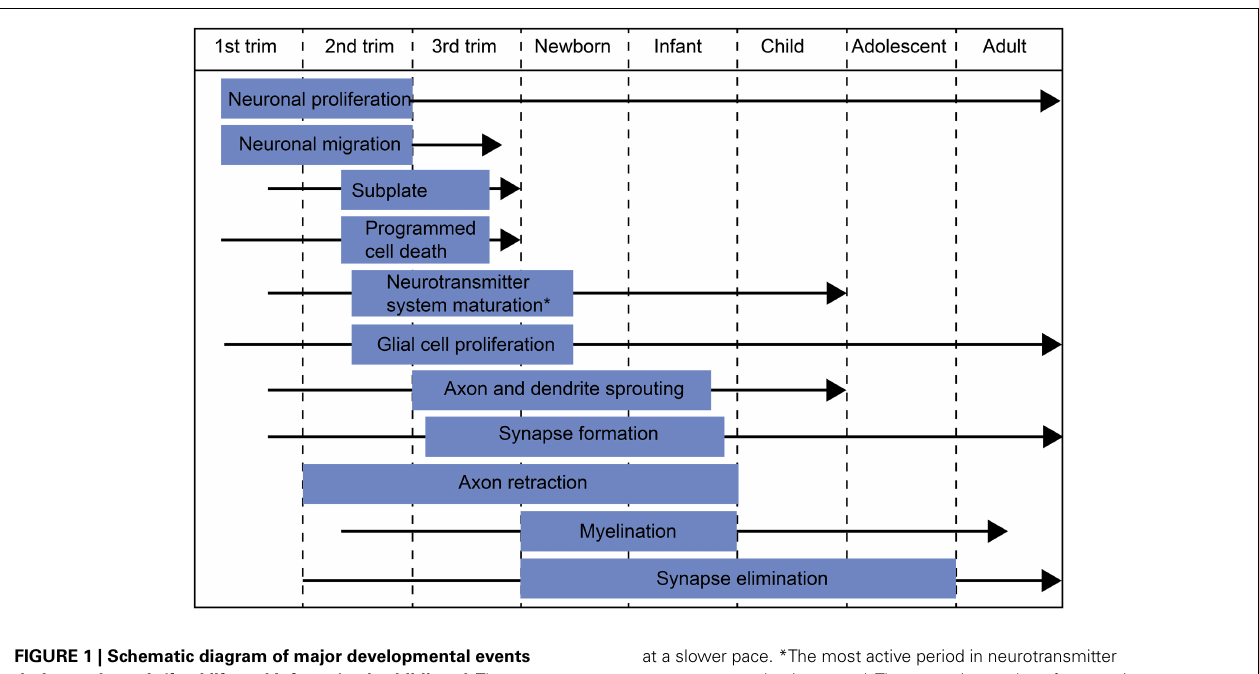
FIGURE 1 | Schematic diagram of major developmental events during embryonic/fetal life and infancy/early childhood .The blue box indicates the most active period of each developmental process and the black arrow the period when the process continues